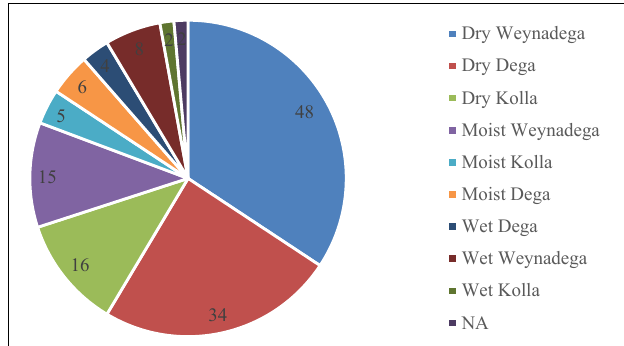
FIGURE 2 | Distribution of publications across the nine traditional agroecologies. The values in each agroecological zone indicate the number of publications. NA refers to no data.